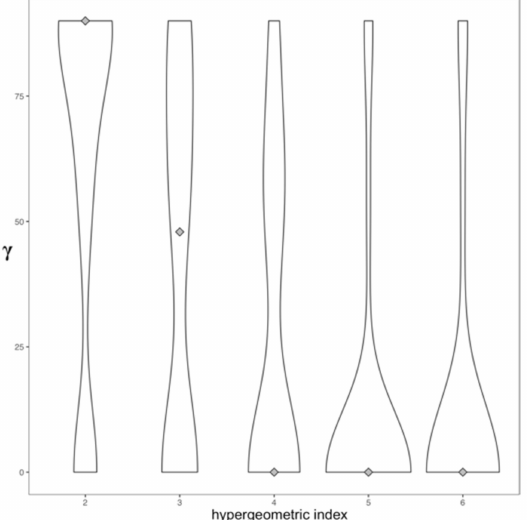
Figure 2. Distribution of drug similarity vectors. The angle ( γ ) of the vectors formed by the similarities of the drug profiles depends on the threshold used for the hypergeometric